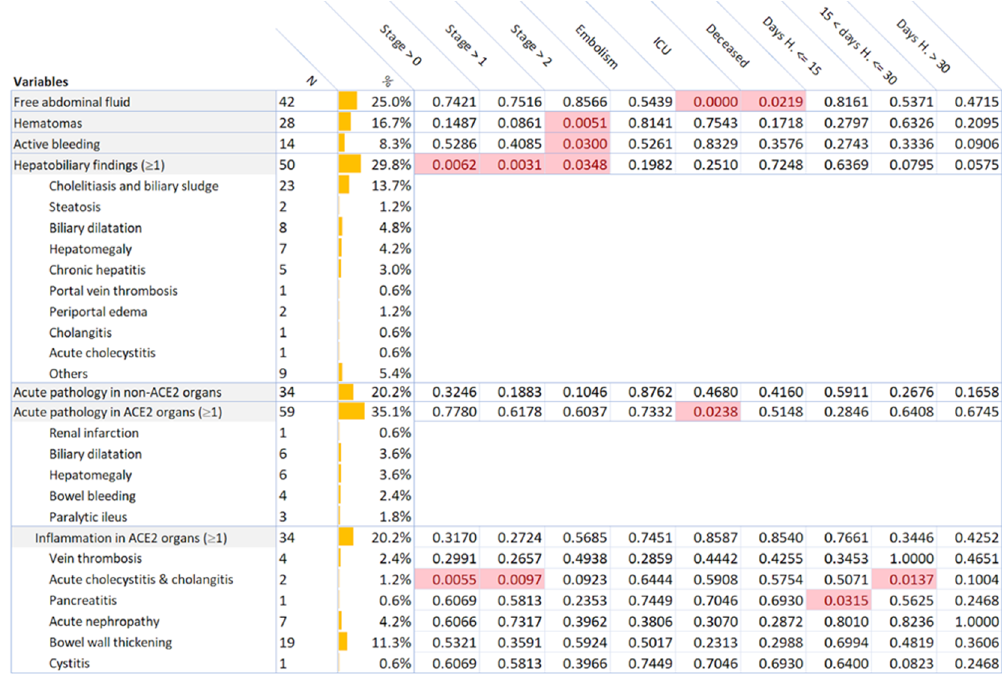
Figure 2. Number of CT abdominal findings, their percentage with respect to all the patients, and the p-value with respect to the patient disease stage, hospitalization history and outcome. Significant values ( p < 0.05) are highlighted with light red background .